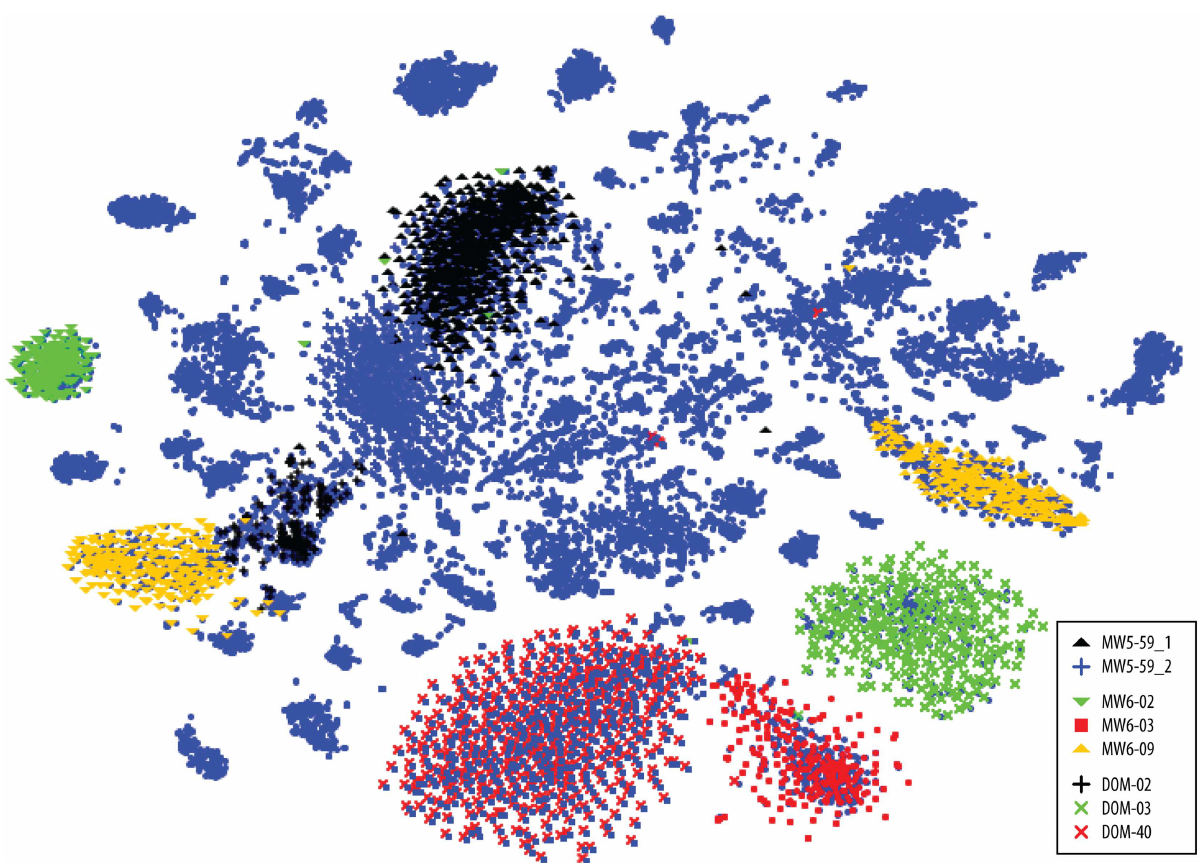
Fig 3. VizBin-based clustering of contigs based on the pentanucleotide (5-mer) frequency distribution shows distinct anammox genomes. Each dot indicatesa specific contig 1000to 5000 bp in length. Color code in the key indicatesidentity of the dots by shape and